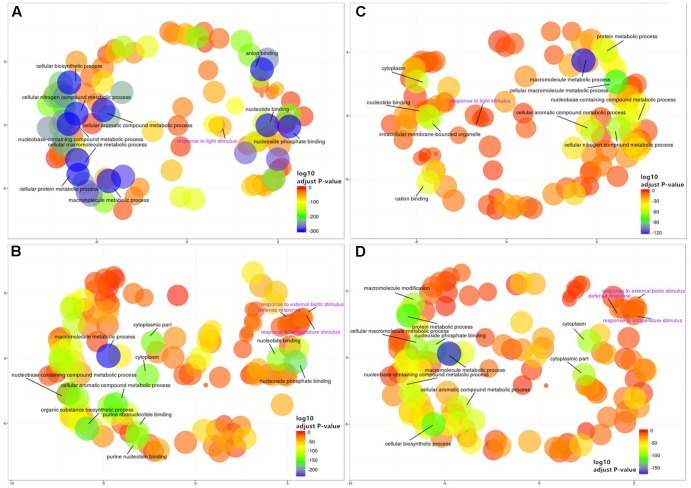
REViGO semantic analysis of differentially methylated GO terms shared by all three regional pairwise comparisons. Functional enrichment of GO-terms was carried out for the genes deemed differentially methylated (DMGs) hypermethylated (185) (A,C) or hypomethylated (211) (B,D) in Northern Grounds compared to Southern Grounds (A,B) and Central Grounds compared to Northern Grounds (C,D) using GO.db and annotate and summarized using REViGO. Bubble color indicates the p-value for the FDRs (the first 10 terms are labeled with legends in black. A detailed list of all GO terms containing DMGs has been supplied as a Supplementary Tables S7 and S8); circle size indicates the frequency of the GO term in the underlying GO database (bubbles of more general terms are larger).